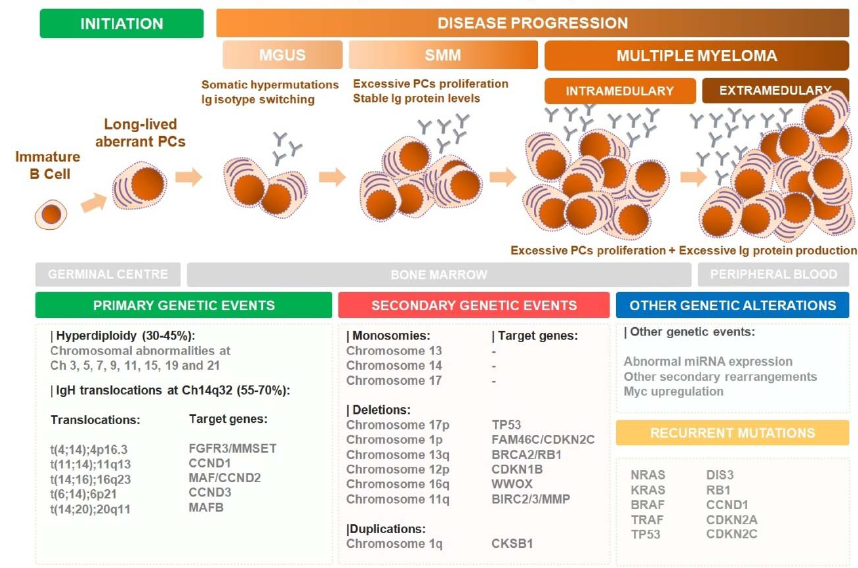
Figure 1. Biology of multiple myeloma (MM) development and progression. MM is the end stage of a multistep neoplastic transformation of PCs. Virtually all MM initiates as a monoclonal gammopathy of undetermined significance (MGUS). In this early stage, a BM PC may accumulate several primary genetic mutations (as chromosomal abnormalities and/or IgH translocations) that affect the expression of key target genes (e.g., cyclins, FGFR3, MYC deregulation, etc.) granting a proliferative advantage to these mutated cells. The presence of abnormal amounts of PCs in the BM with slightly increased levels of Ig proteins but no clinical symptoms is defined as smoldering multiple myeloma (SMM). Nevertheless, these hyperproliferative PCs will endure additional secondary genetic mutations that aggravate this aberrant phenotype leading to the accumulation of high amounts of PCs in the BM and consequently to the secretion of excessive levels of Igs towards the blood stream. Ultimately, this will lead to the clinical manifestation of severe symptoms (as hypercalcemia, renal insu ffi ciency, anemia and bone lesions) that define MM. This disease may progress to extramedullary disease in more advanced stages. Additional aberrant genetic events, such as mutations, deletions, methylations and microRNA (miRNA) abnormalities may occur during MM development defining the aggressiveness of the disease and response to